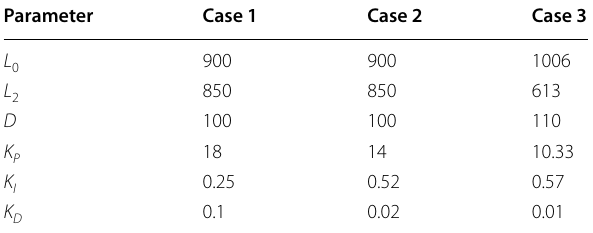
Table 3 Optimization results